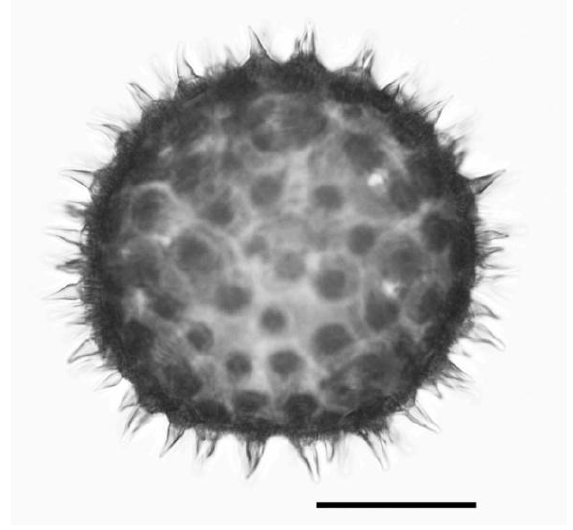
F IGURE 2. Light microscope micrograph of cotton pollen (Gossypium hirsutum C. Linnaeus). Bar = 50